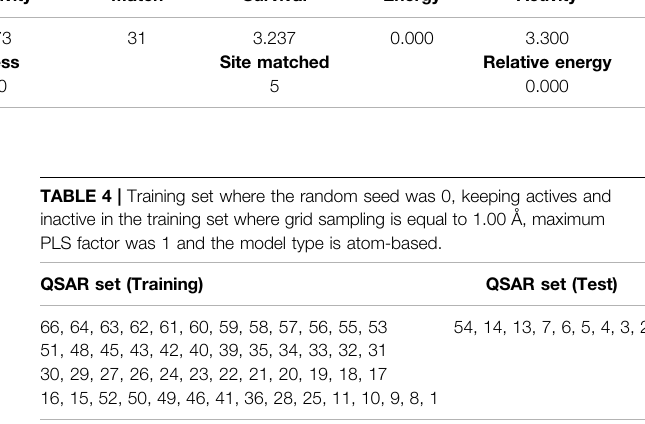
TABLE 3 | Score hypotheses of ADPRR.18 where site, volume, and matches are listed with alignment for a hypothesis of ADPRR.18 where compound number 25 is observed to be a more valid and suitable one. Site Vector Volume